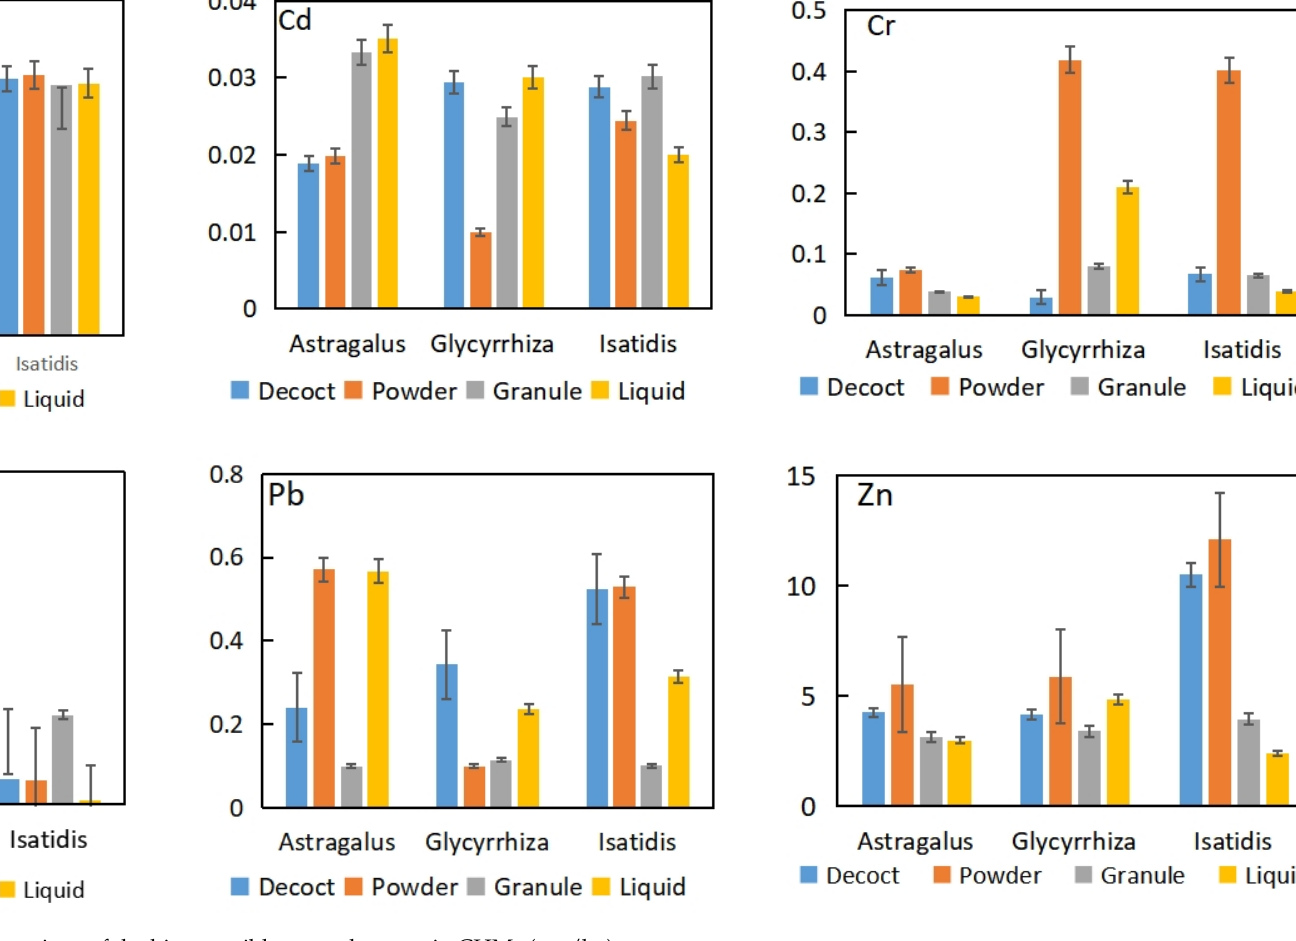
Figure 3. Concentrations of the bioaccessible trace elements in CHMs (mg/kg).